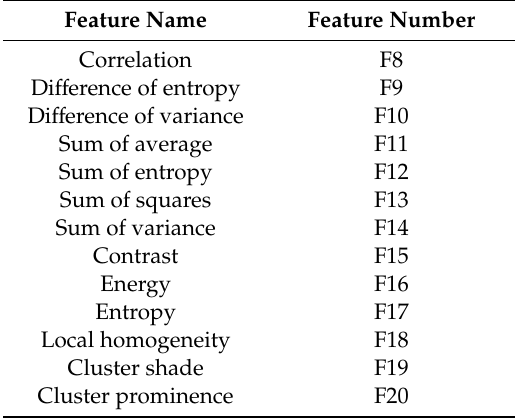
Table 3. Gray-level spatial dependence matrix feature sets.